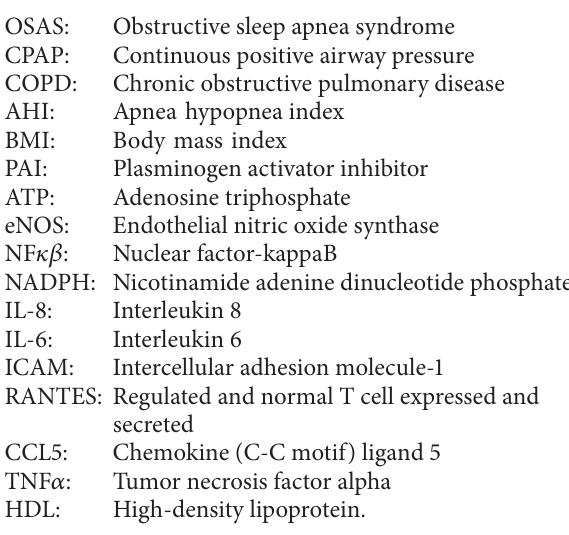
COPD alone [214]. Individuals with overlap syndrome are at greater risk for pulmonary hypertension, right heart failure, and hypercapnia than patients who have either COPD or OSAS alone